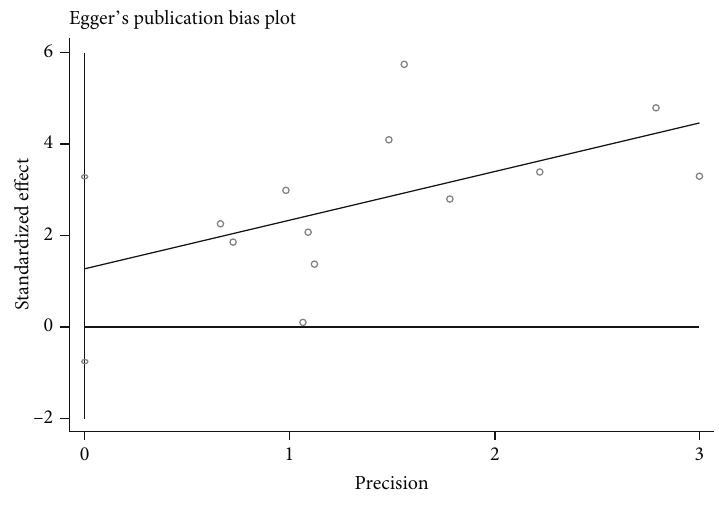
Figure 10: Egger ’ s publication bias plot.